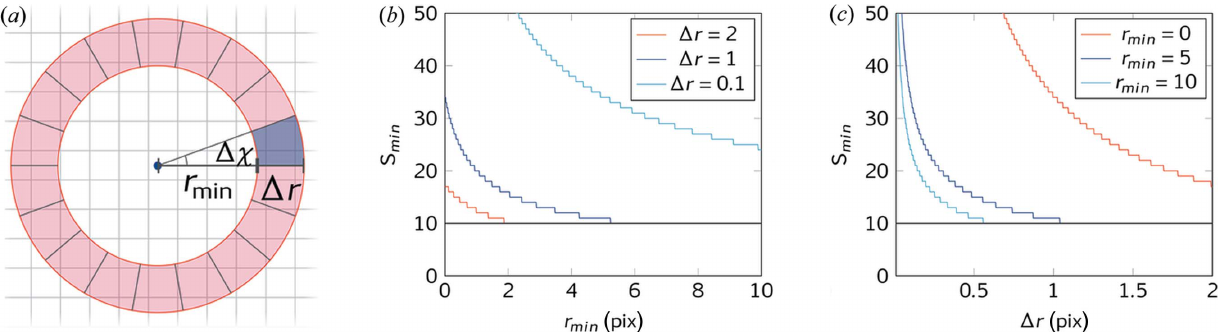
Figure 2 Minimum splitting factor. ( a ) Splitting area illustration. The blue dot shows the beam center, the red shaded area corresponds to the 1D 2 (cid:2) bin with a full integration and the blue shaded area corresponds to a possible (2 (cid:2) , (cid:3) ) resolved bin with (cid:2) (cid:3) = N Ab /2 (cid:5) . ( b , c ) Graphs of the minimum pixel-splitting curve with N Ab = 360 and (cid:4) sp = 5 as a function of ( b ) r min and ( c ) (cid:2) r